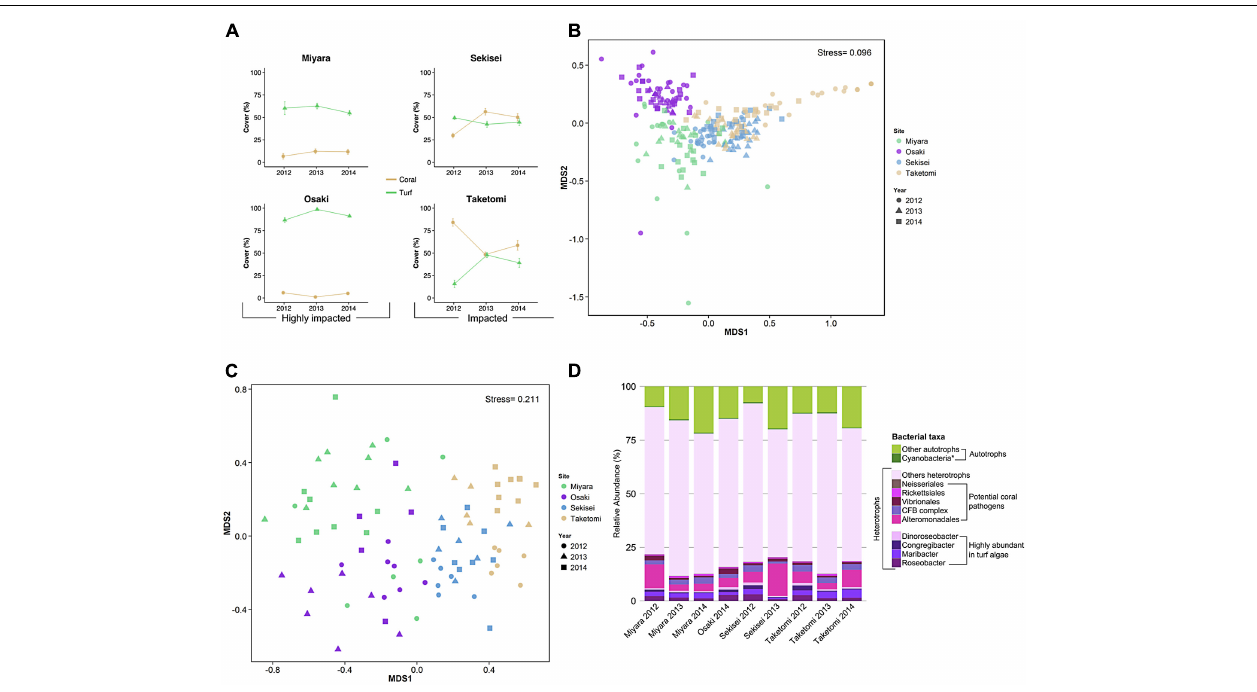
FIGURE 2 | Coral reefs from Ishigaki Island are impacted at different levels. Yellow and green lines represent coral and algal cover in percentages for the reef sites and years, respectively (A) . The first two axes of non-metric multidimensional scaling (nMDS) based on benthic cover (B) and fish abundance (C) show each benthic sample replicate using different colors for sites and different shapes for years. The taxonomic compositions of water metagenomes, heterotrophic bacteria, potential coral pathogenic bacteria, and highly abundant bacteria in turf algae are represented by different colors (D) . The asterisk in Cyanobacteria represents the bacterial genera Anabaena , Nostoc , and Trichodesmium (cyanobacteria genera commonly found in turf algae). CFB complex, Cytophaga–Flavobacterium–Bacteroides